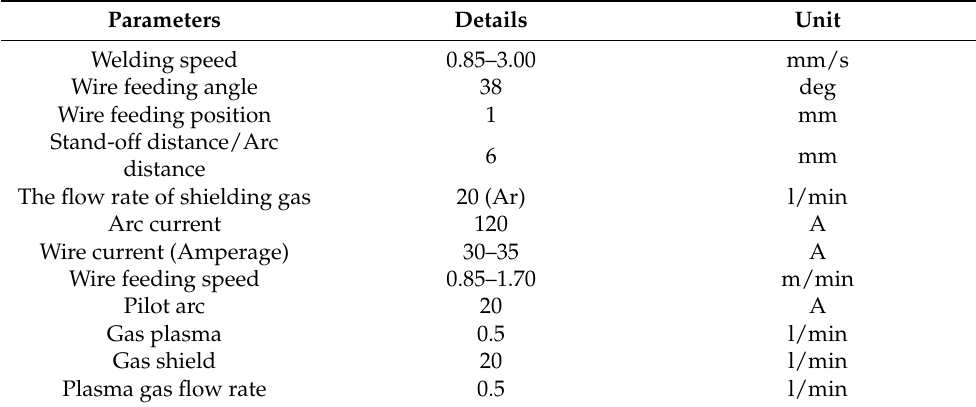
Table 4. The parameters used for the hot-wire plasma welding